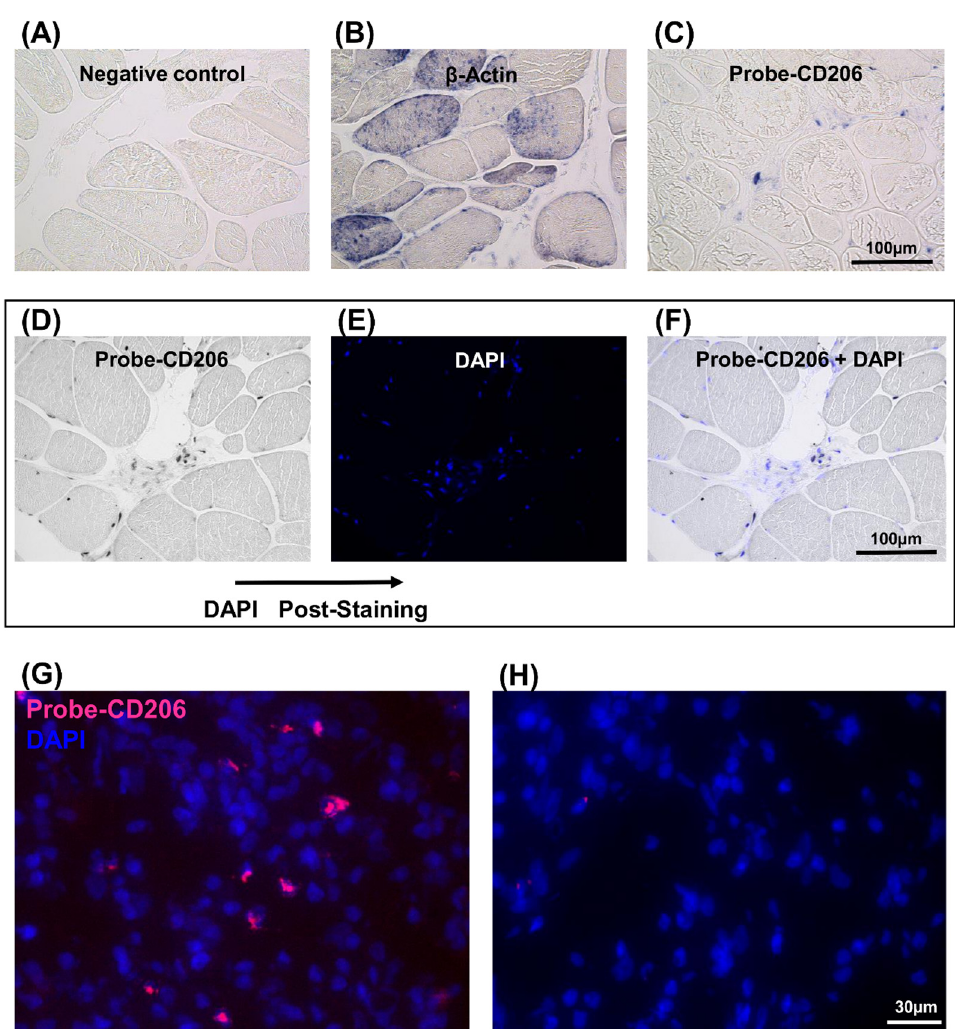
Figure 4. Detection of CD206 expression in the IR-ASC muscle by in situ hybridization. ( A – F ) In situ-DIG; ( G , H ) In situ-HCR. ( A ) Negative control. ( B ) Expression of β -actin mRNA (positive control). ( C ) Expression of CD206 mRNA. ( D – F ) For the quantification, slide was post-stained with DAPI. ( D ) Expression of CD206 mRNA. ( E ) Nuclear staining with DAPI (blue fluorescence). ( F ) Both CD206 mRNA and DAPI staining. ( G ) Expression of CD206 mRNA. ( H ) Negative control of G. Probe-CD206 (Alexa546, red fluorescence), nuclear staining with DAPI (blue fluorescence).